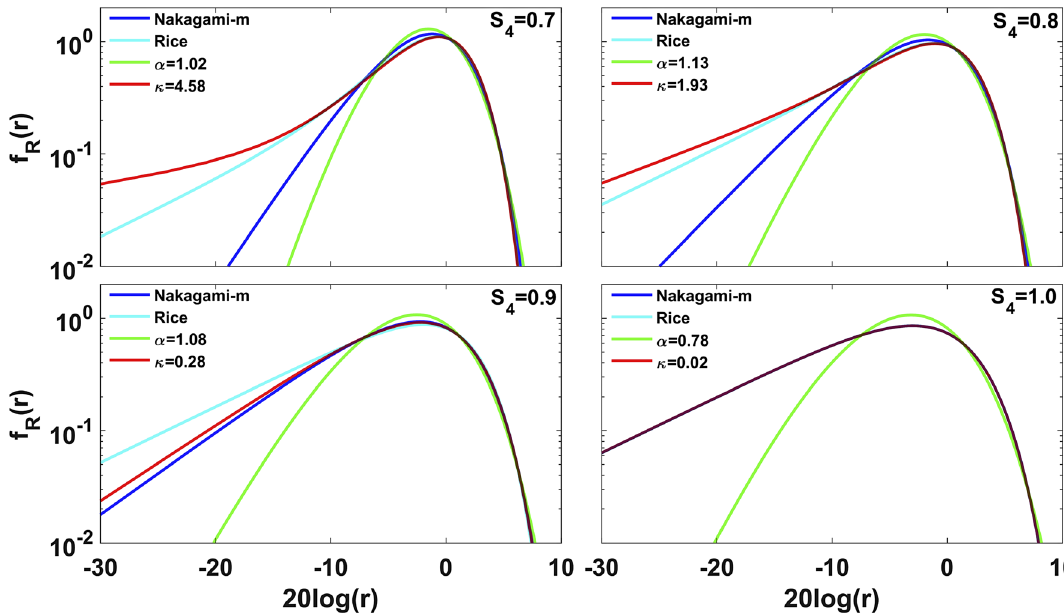
Fig. 10. Comparison between a - l and j - l